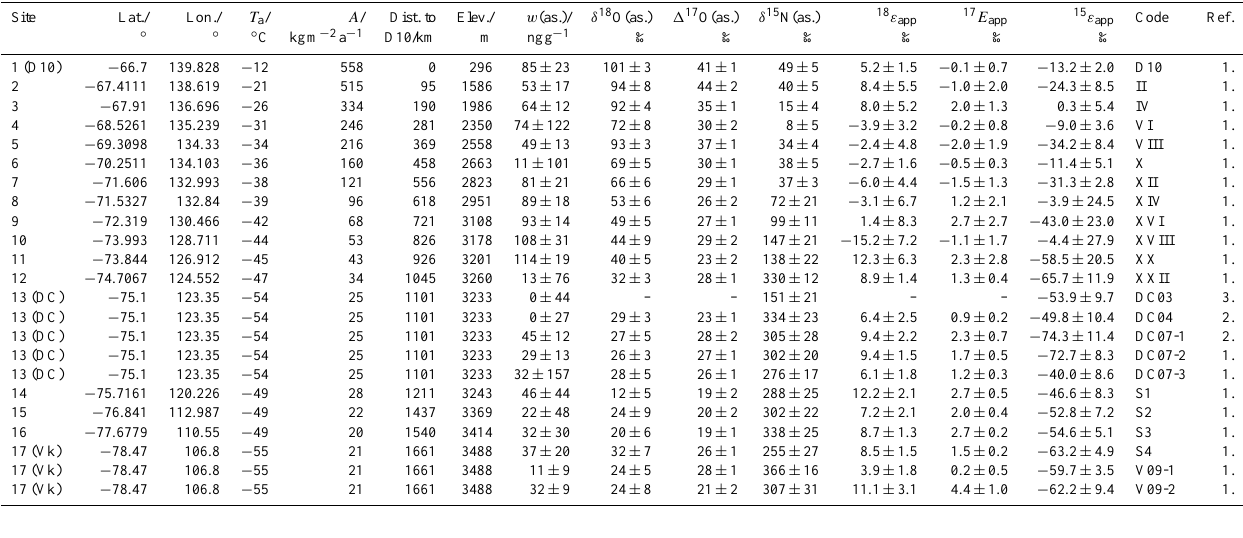
Table 1. Asymptotic nitrate isotopic composition ( δ 18 O(as.), 1 17 O(as.) and δ 15 N(as.)) and apparent isotopic fractionation constants ( 15 ε app , 17 E 18 ε 18 O, 1 17 O and δ 15 N, respectively) observed in snow pits across East Antarctica together with all of the existing app and app for δ data previously published for this area: (1) this study, (2) Frey et al. (2009) and (3) Blunier et al. (2005). Mean annual 2m temperatures are derived from the ERA-Interim reanalysis over the 2000–2008 period (Dee et al., 2011) or from observations for the Dome C and Vostok sites. One- σ uncertainties in the fractionation constants are based on the propagation of the error in the isotope ratios (this study and Frey et al., 2009, after Taylor, 1997) and Monte Carlo analysis for the Blunier et al. (2005) results. One- σ uncertainties in the asymptotic values are obtained as explained in the method section.